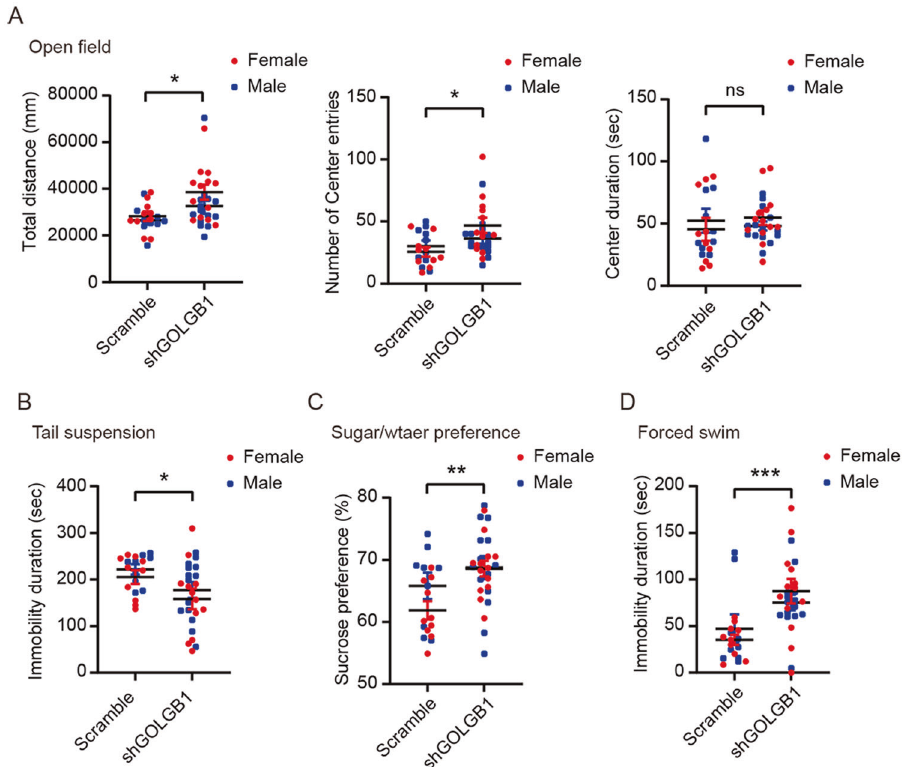
Fig. 3 Downregulation of Golgb1 causes BD-like behaviors in mice. Mice of both sexes injected with AAVs expressing shGOLGB1 or a scrambled control shRNA were subjected to behavioral tests at 2 months of age. A In the open fi eld test, mice were studied for their total travel distance, their numbers of center entries, and their duration time in the center. B In the tail suspension test, mice were studied for their immobility duration during the tail suspension. C In the 2-bottle choice sucrose preference test, mice were studied for their preference for sucrose. D In the forced swim test, mice were studied for their immobility duration in water. n = 27 (13 females and 14 males) for shGOLGB1 mice, n = 19 (ten females and nine males) for scrambled control mice; ns not signi fi cant, * p < 0.05, ** p < 0.01, *** p < 0.001; two-tailed Student ’ s t